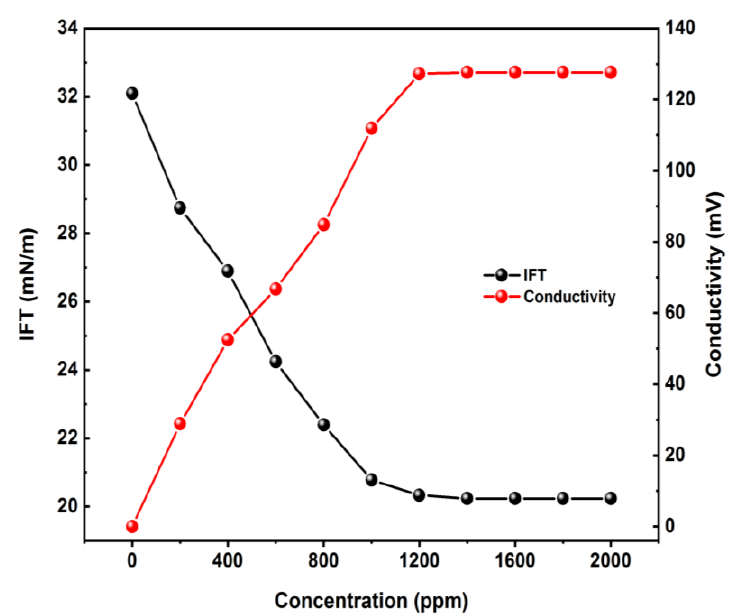
Figure 3. Surface conductivity and IFT versus Azarboo concentration for CMC determination.